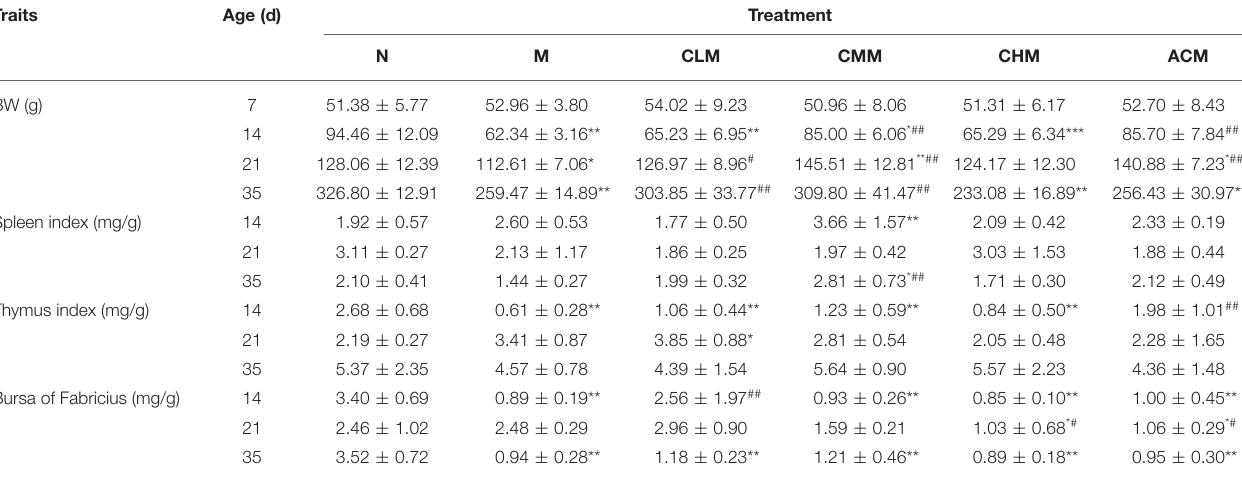
TABLE 1 | Effects of CSP on body weight and immune organ index of immunosuppressed chickens. Traits Age